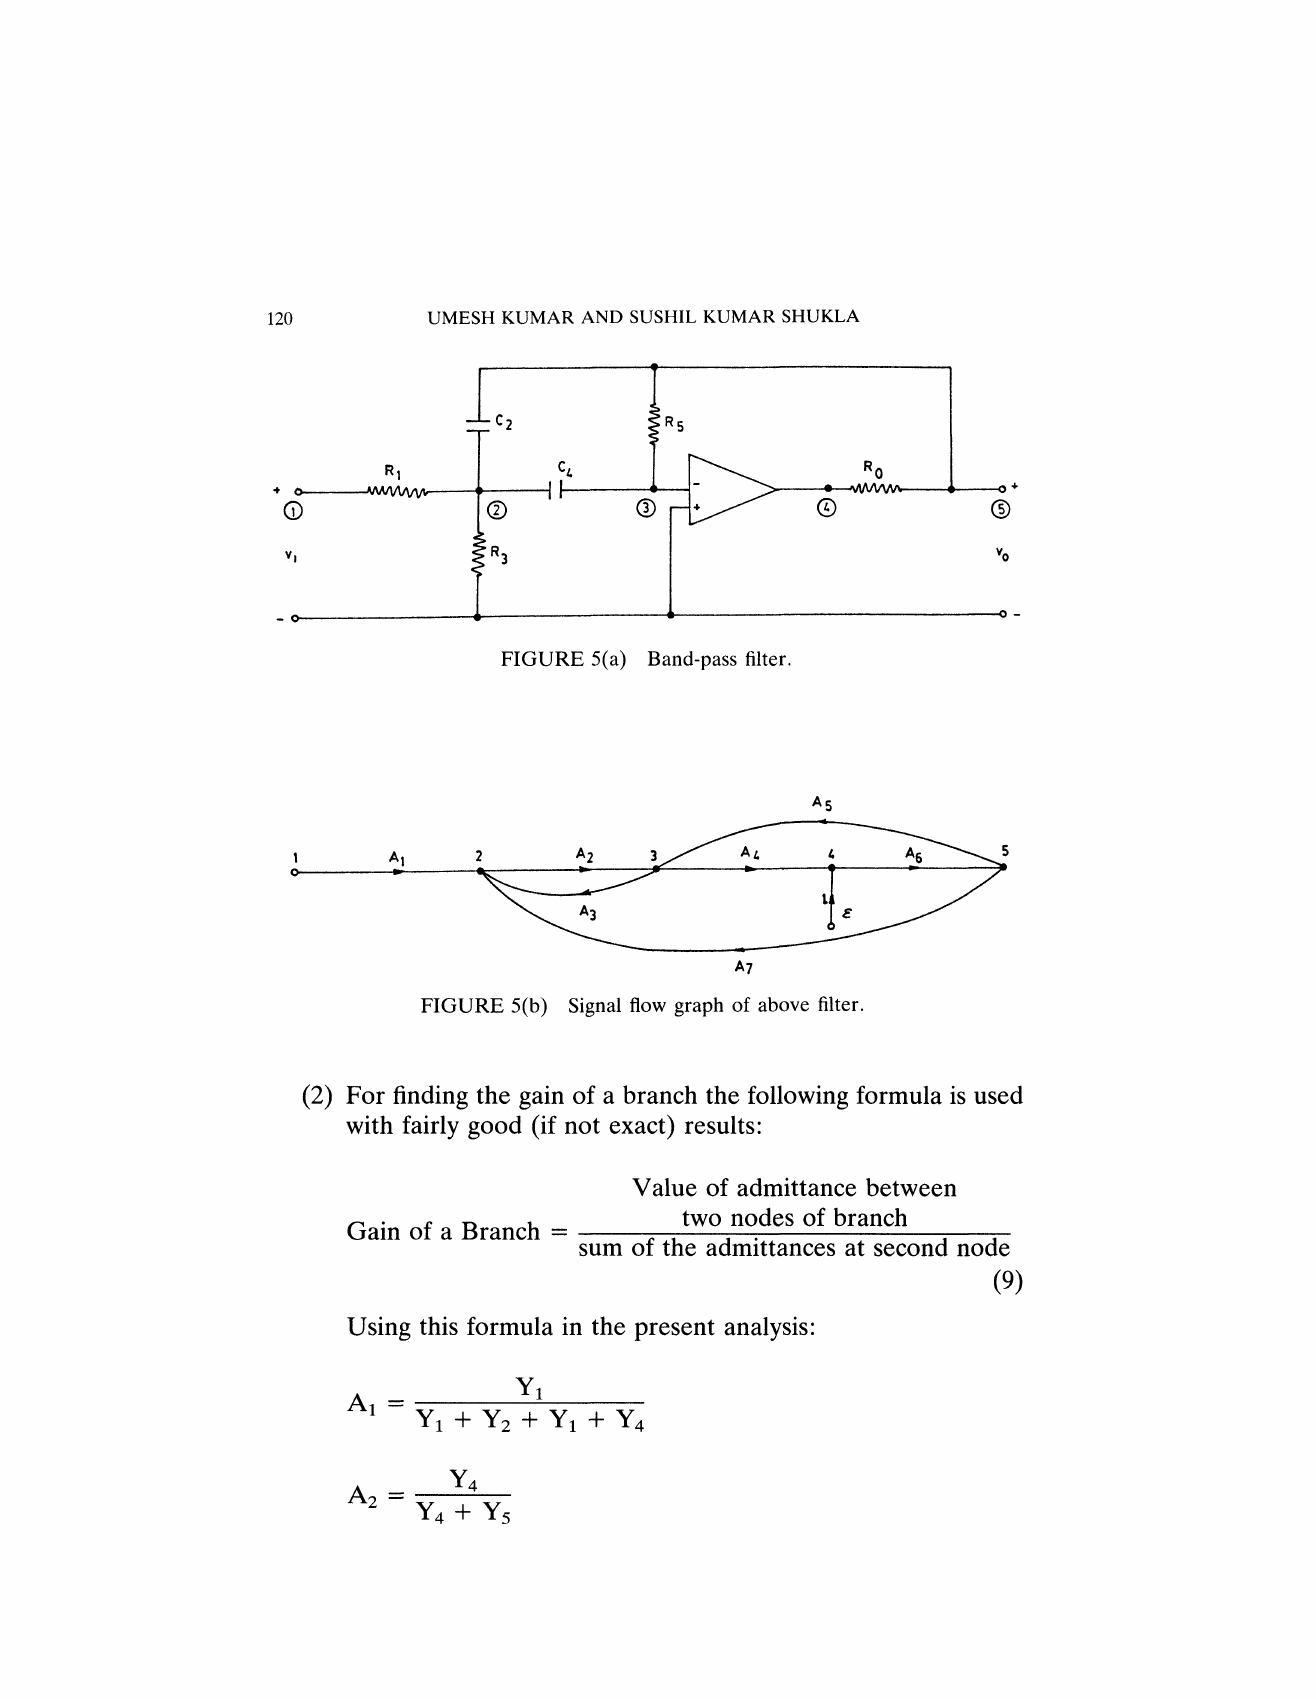
FIGURE 5(a) Band-pass filter.